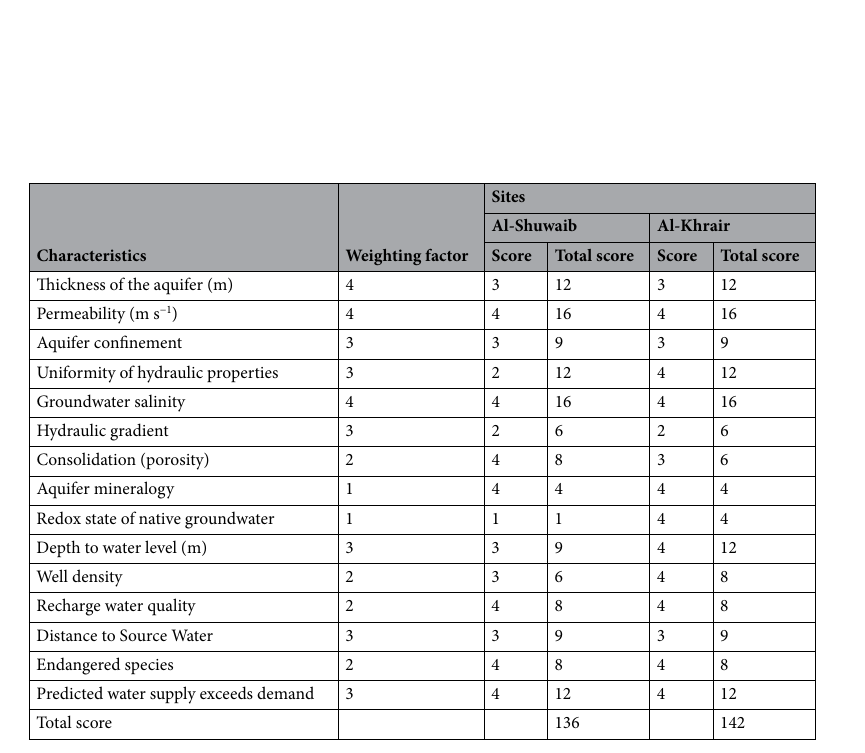
Table 2. Aquifer storage and recovery (ASR) scores for Al-Shuwaib and Al-Khrair by applying the weighting factor.